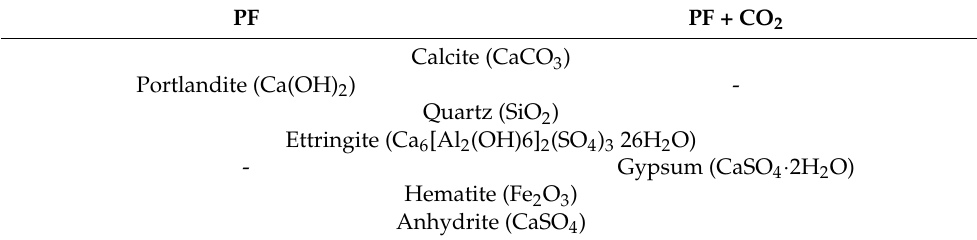
Table 3. Main products of hydration and carbonation of ash–water